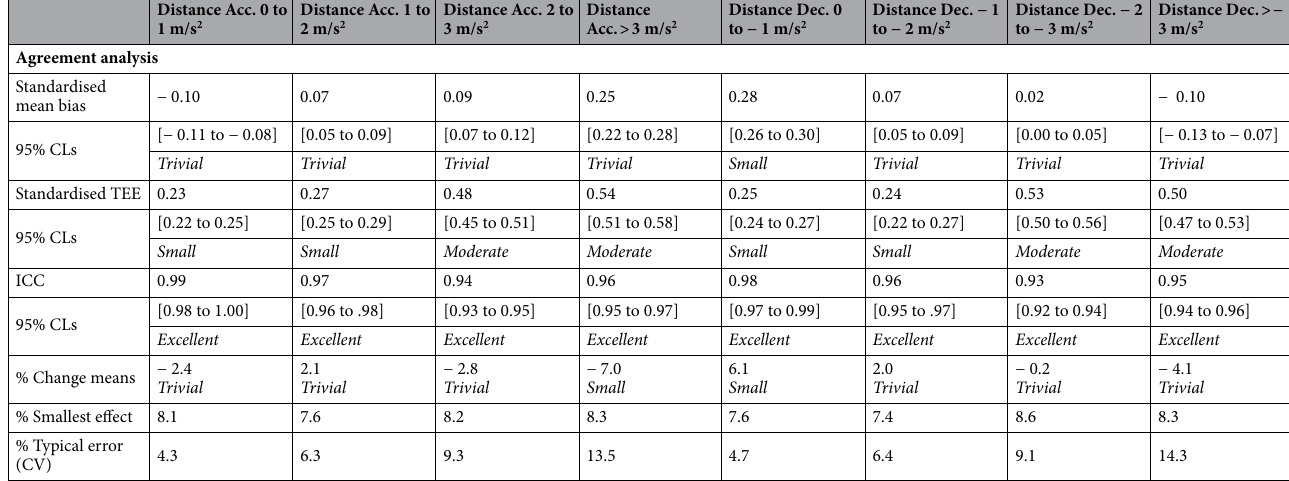
Table 4. Comparison of each variable in distances covered in different acceleration/deceleration sections analyzed by Mediacoach and WIMU data, including standardized mean bias, typical error of estimate (TEE), intraclass correlation coefficient (ICC), % change mean, % smallest effect and % coefficient of variation (CV), all with 95% confidence limits. Acc . acceleration, Dec . deceleration, CLs confidence limits.